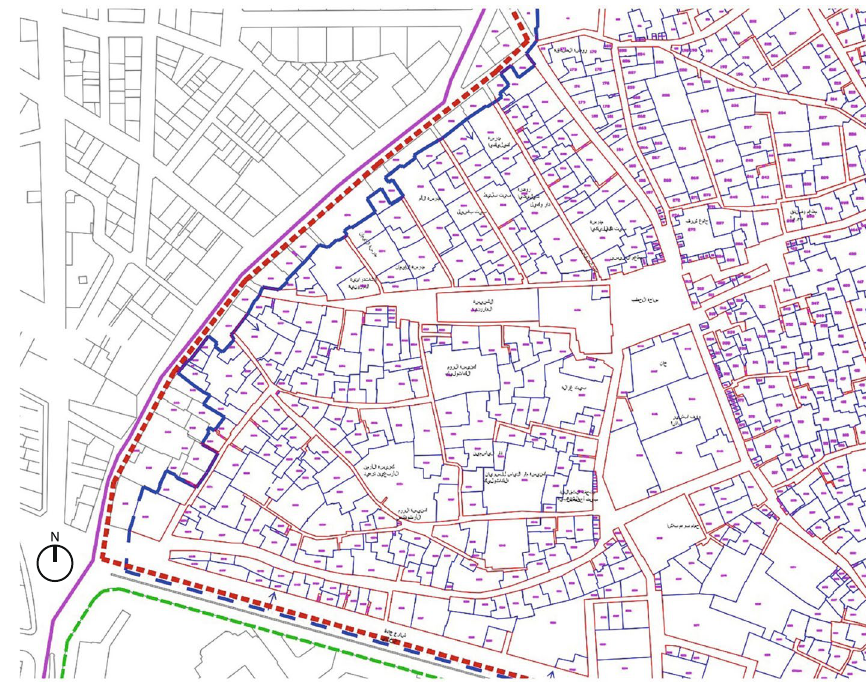
Fig. 5 The Al-Judayda Area as Shown in the Map of Aleppo created in the 2000s (Source: GTZ and DOCA